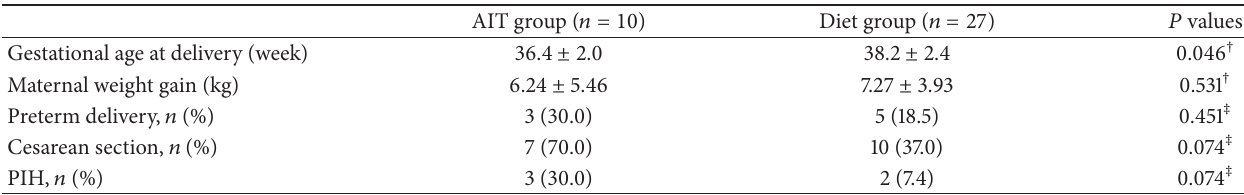
Table 5: Obstetrical